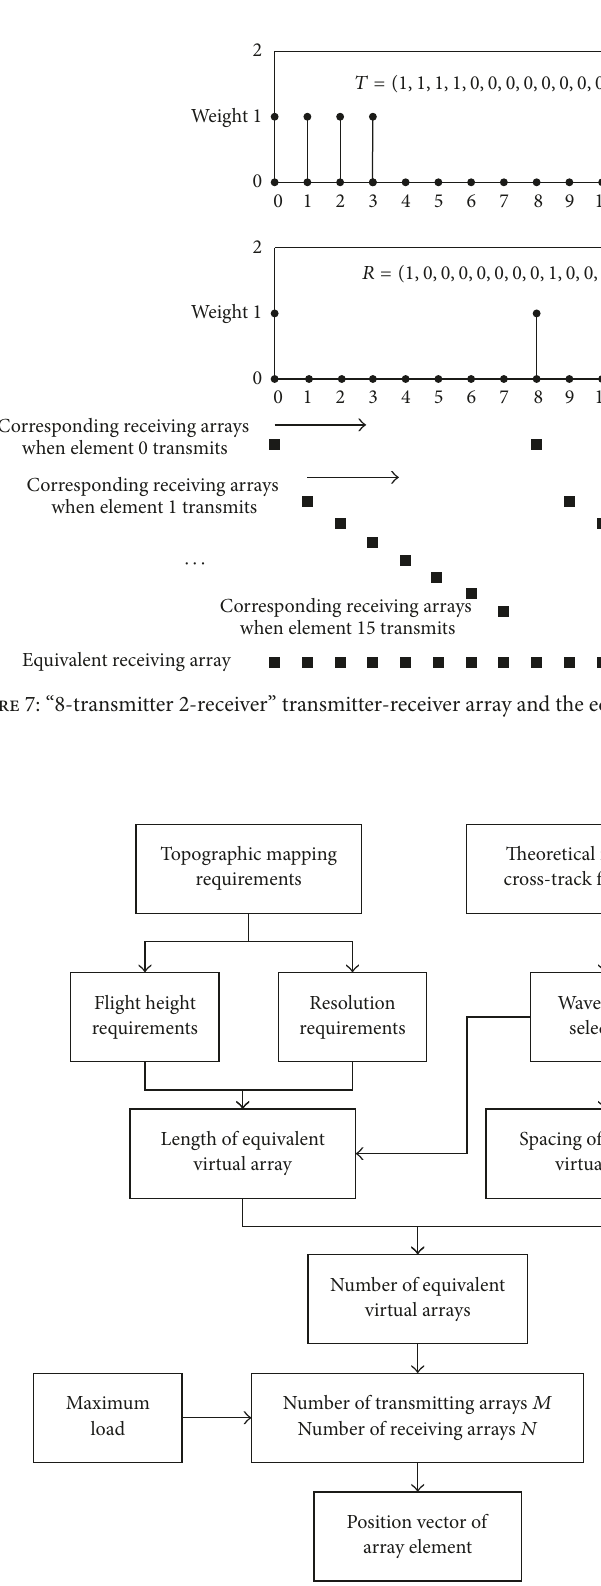
Figure 8: Flow chart of array antenna